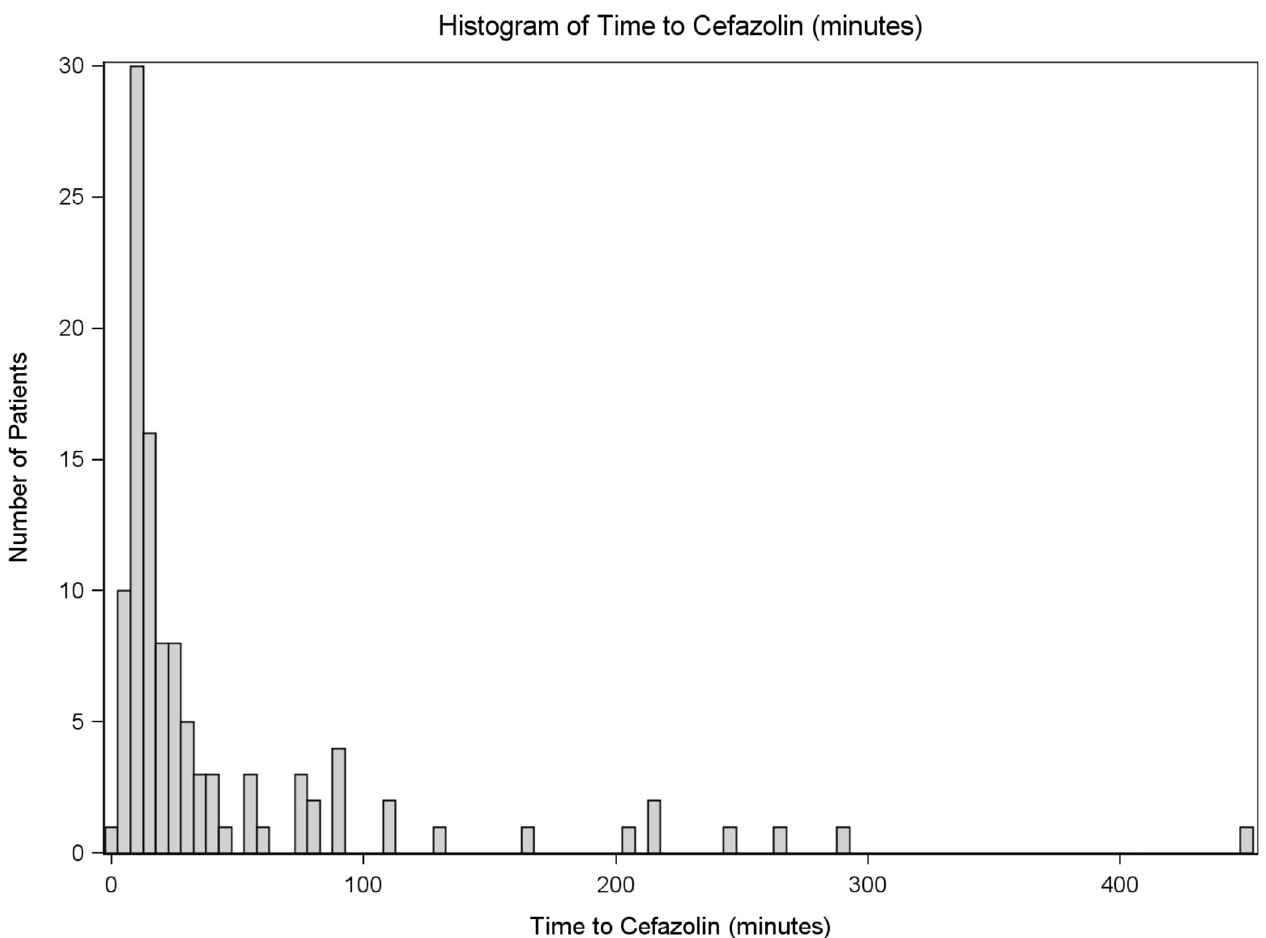
Fig 1. Timing of cefazolin for all patients. Demonstration of the distribution of patients and their associated time to cefazolin administration. Patients are not classified based on open fracture type or triaging group.